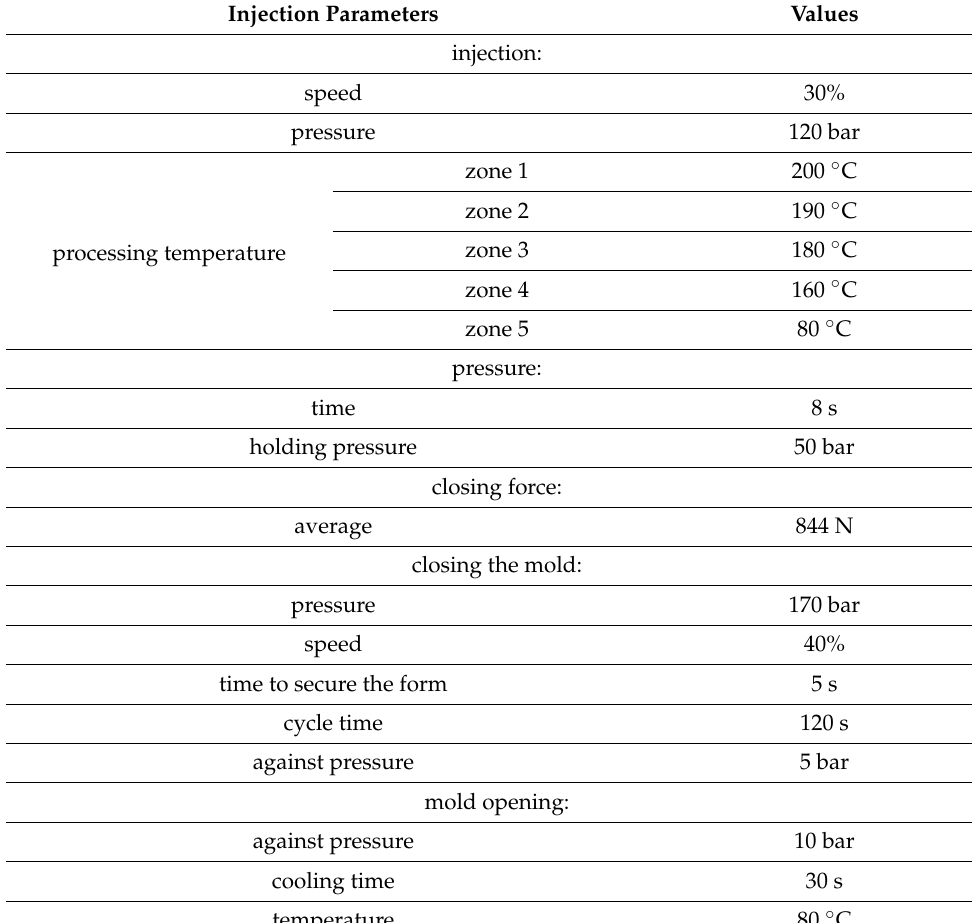
Table 4. The parameters of the sample injection